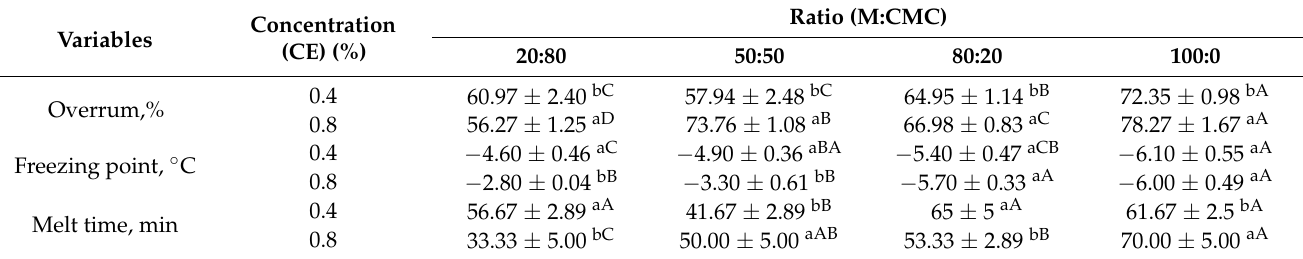
Table 5. Physical stability variables measured for vanilla-flavored soft serve ice